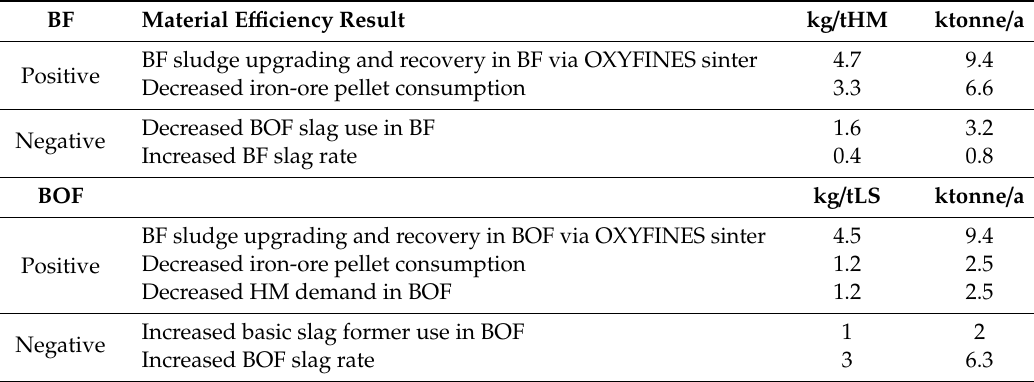
Table 5. Summarised results of potential material e ffi ciency from the system